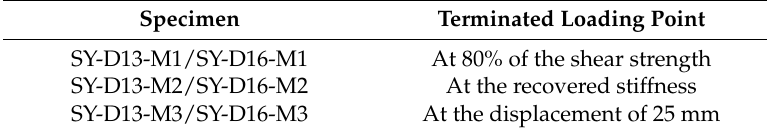
Table 4. List of push-out tests.